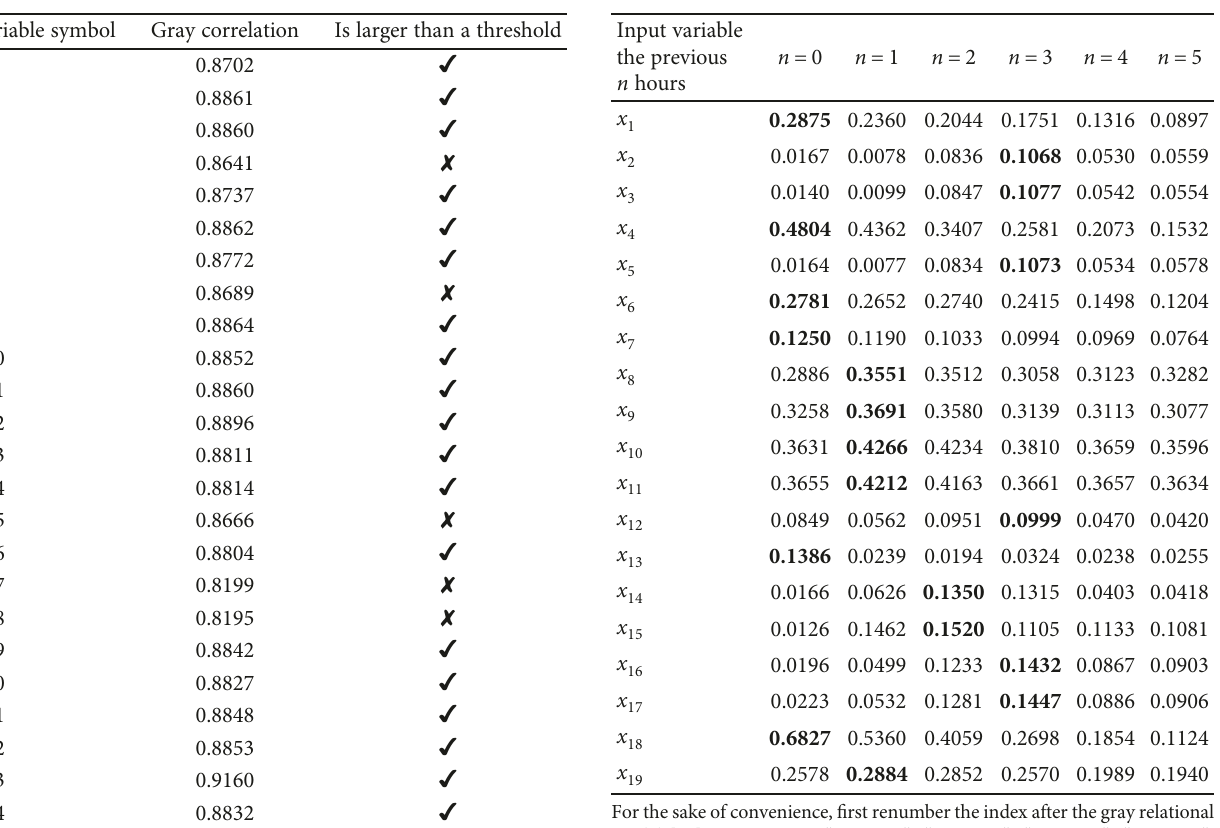
Table 1: List of results of alternative input indicator and [Si]% gray relational degree solving.